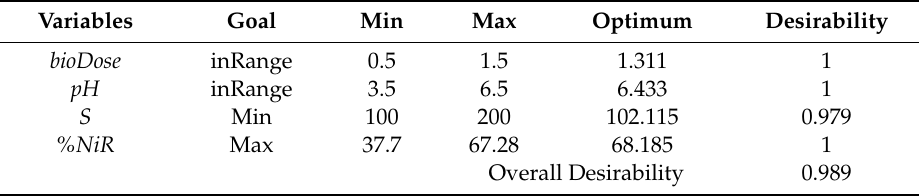
Table 9. The second biosorption optimization scenario: minimizing the energy consumption (minimizing stirring speed) to obtain the highest Ni(II) removal e ffi ciency.